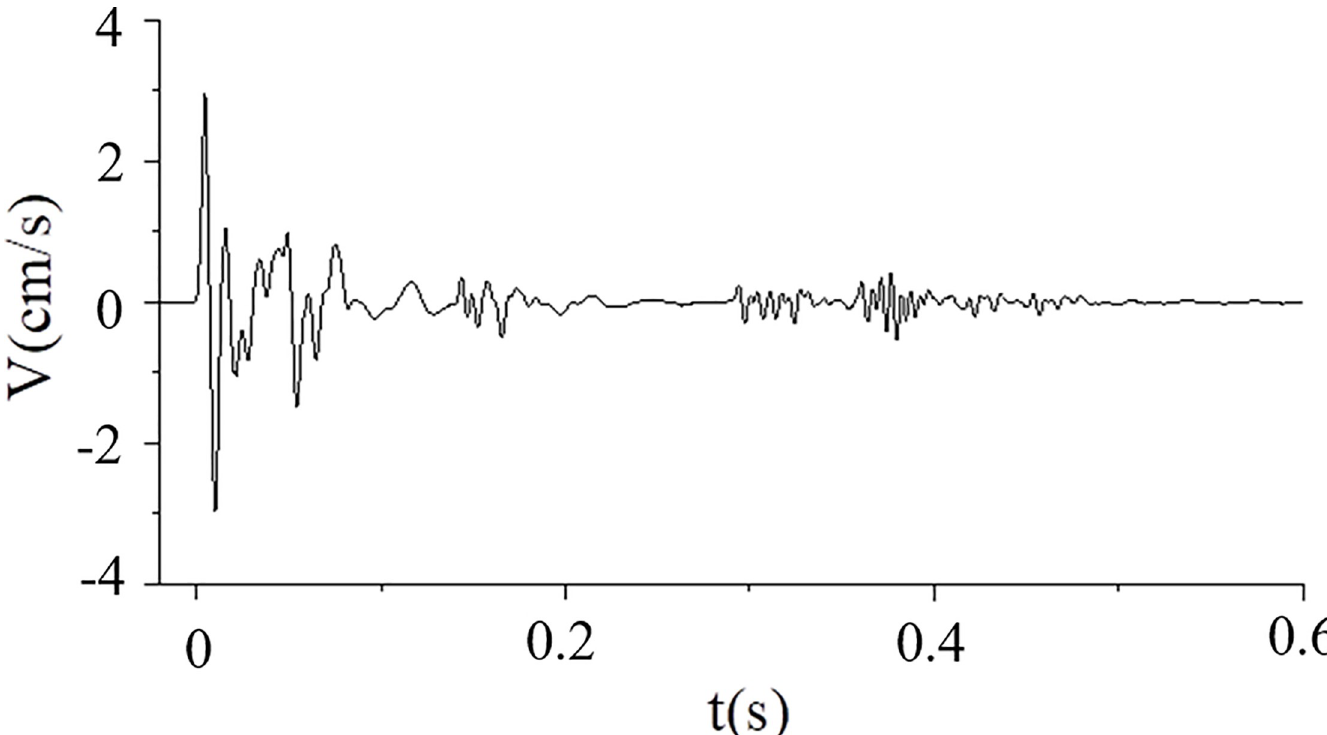
Fig 8. Velocity of tunnel blasting using non-electric detonators (Part I blasting).